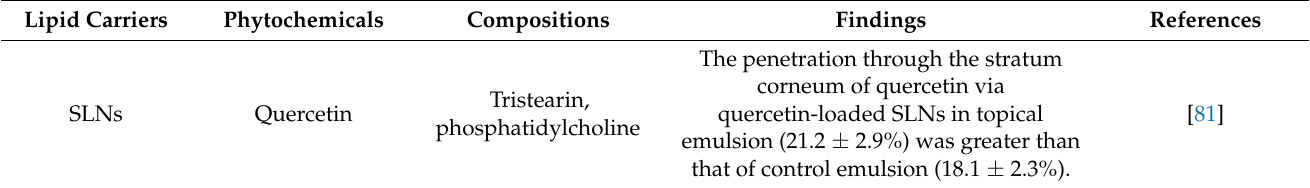
Table 1. Examples of SLNs and NLCs loaded with anti-acne phytochemicals. Lipid Carriers Phytochemicals Compositions